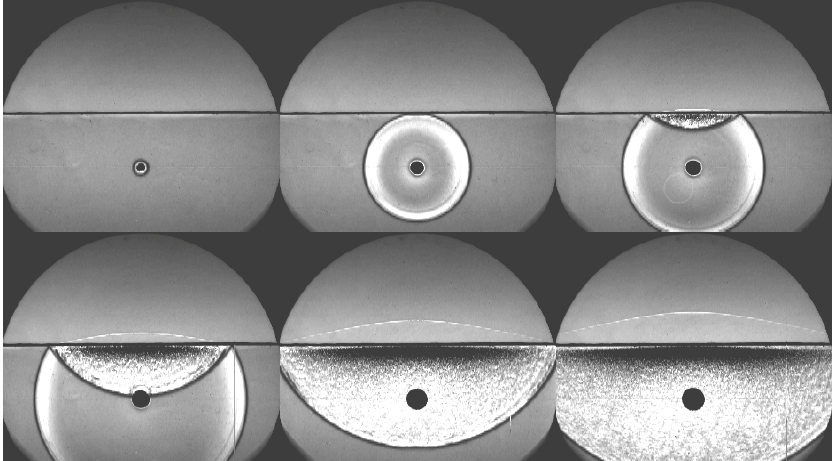
Figure 4. Shockwave propagation at a water surface, captured by ISIS camera [4,5] at 500,000 fps (taken by Prof. H. Kleine, University of South Wales,